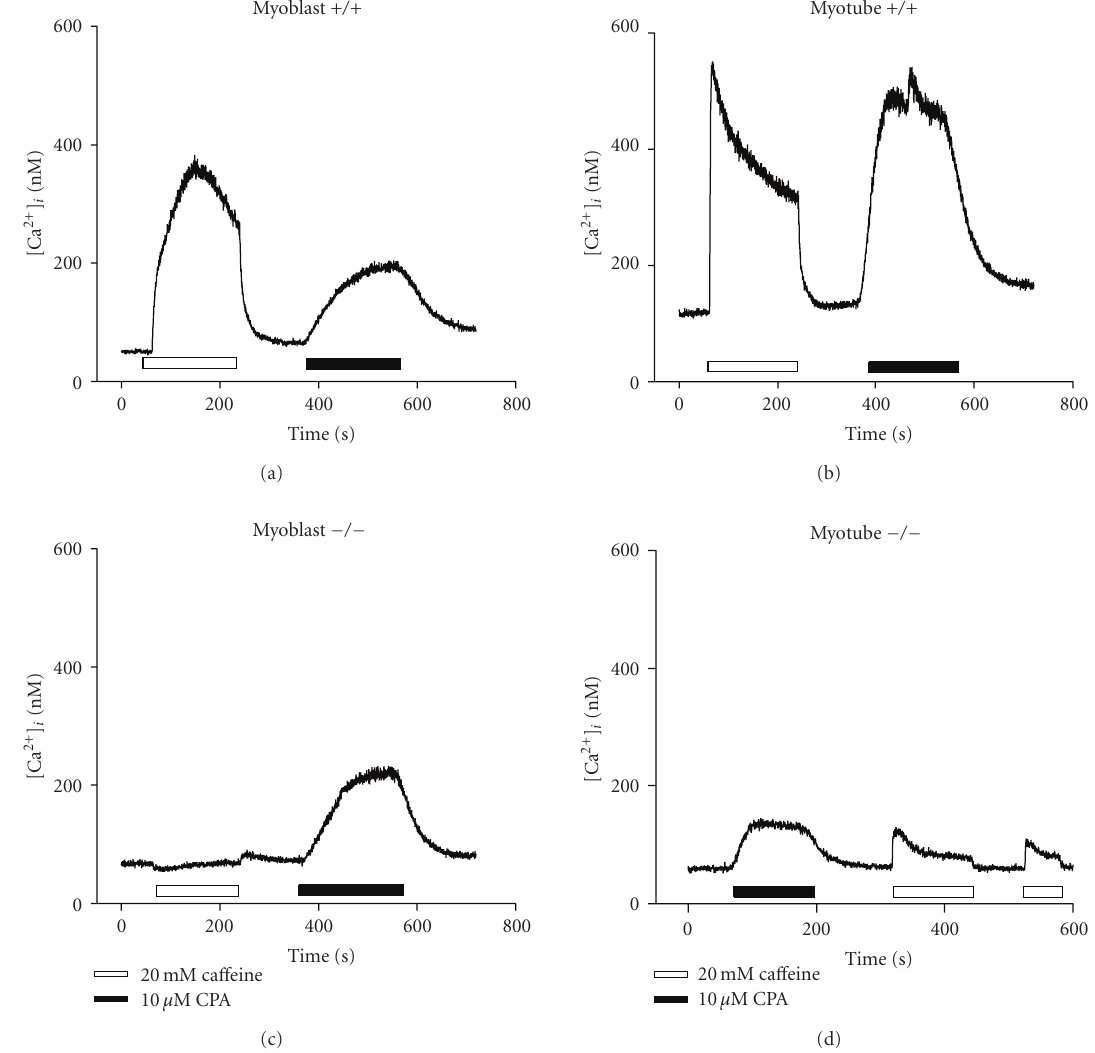
Figure 4: E ff ect of ca ff eine and CPA on [Ca 2+ ] i in isolated myoblasts and myotubes. Representative traces show the typical time course of the response to 20 mM ca ff eine and 10 μ M CPA observed in (a) wild type (+/+) myoblast; (b) wild type (+/+) myotube; (c) calpain 3-deficient ( − / − ) myoblast; (d) calpain 3-deficient ( − / − ) myotube. The duration of exposure to ca ff eine (open bars) and CPA (gray-dashed bars) is